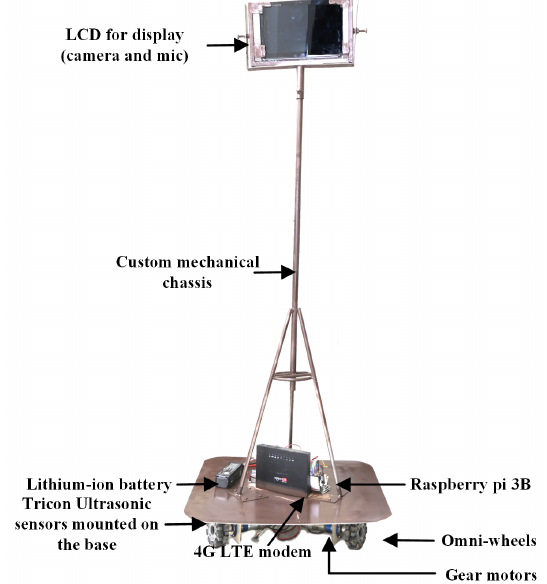
Figure 12. Final hardware demonstration of tele-presence robot